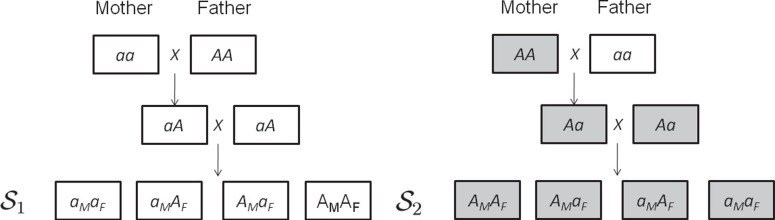
A reciprocal F2 design.